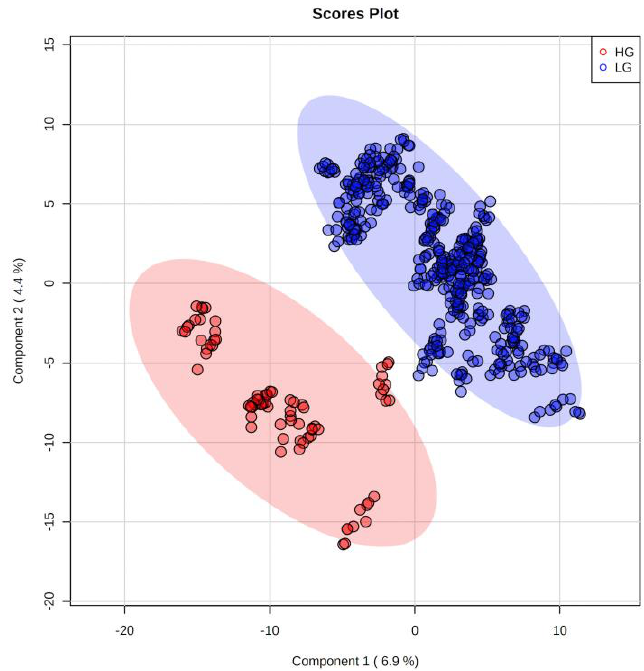
Figure 1. Partial least squares-discriminant analysis of the metabolites revealing the separation be- tween low- and high-grade meningioma cases.